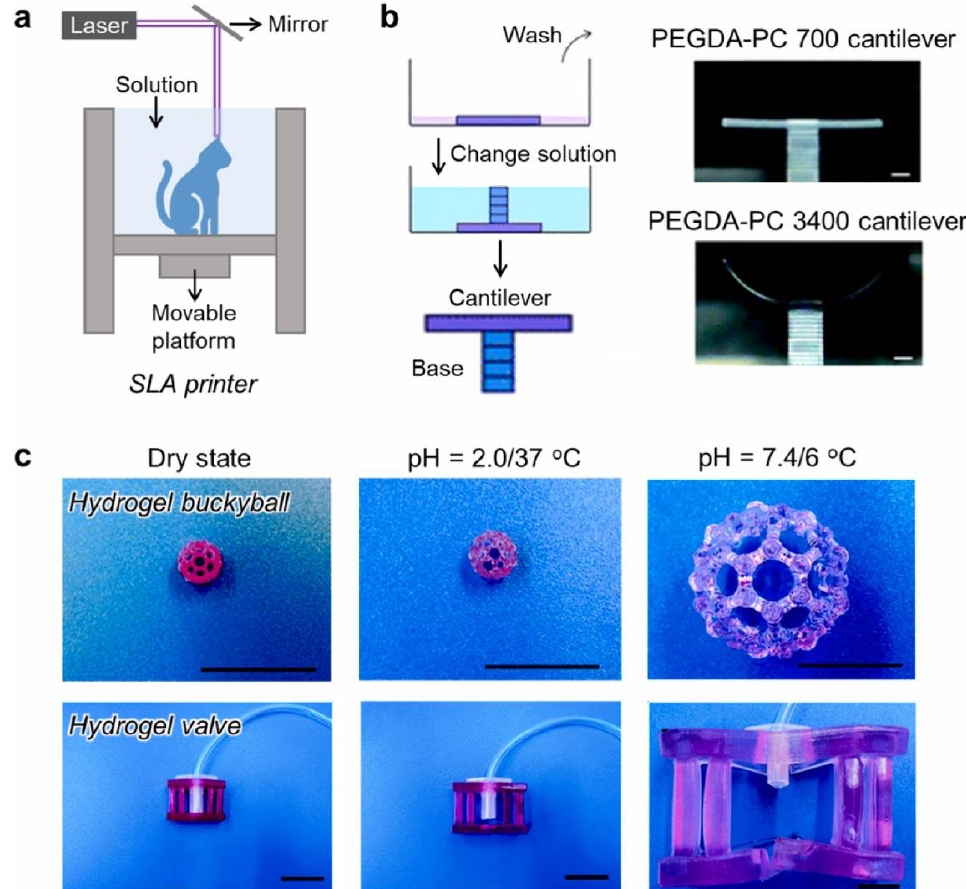
Figure 5. ( a ) Schematic of SLA 3D printer. ( b ) SLA printed hydrogel cantilevers with different molecular weight (700/3400 Da) of PEGDA. Scale bar, 1 mm. ( c ) SLA printed hydrogel buckyball and valve at different condition. Scale bar, 2 cm. Reprinted with permission from Elsevier [152].